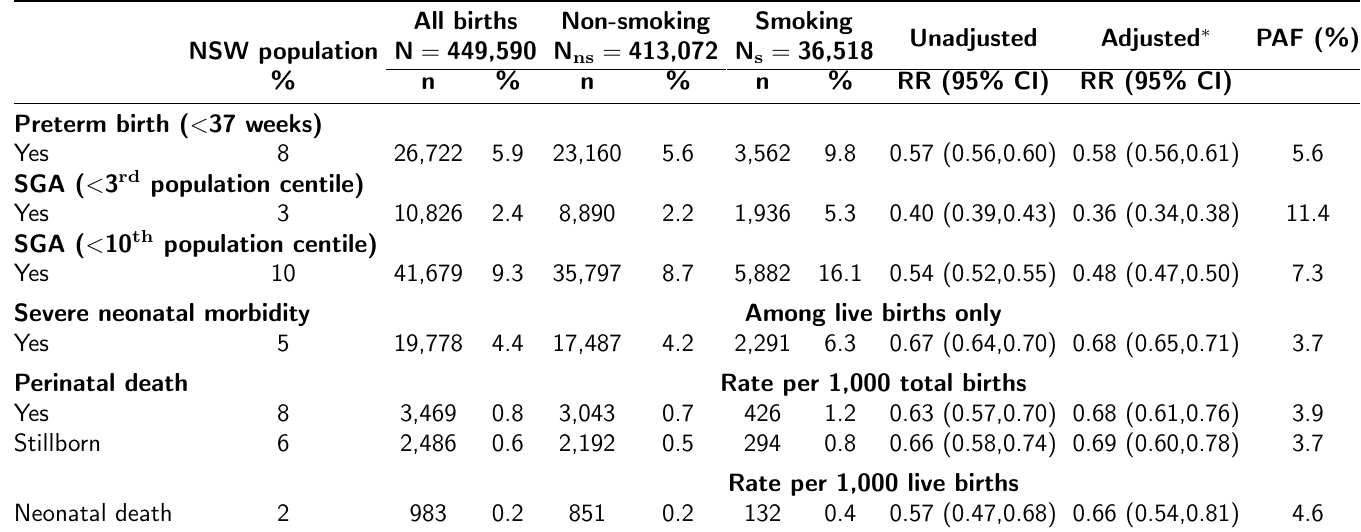
Table 3: Frequencies of perinatal outcomes among by maternal smoking status All